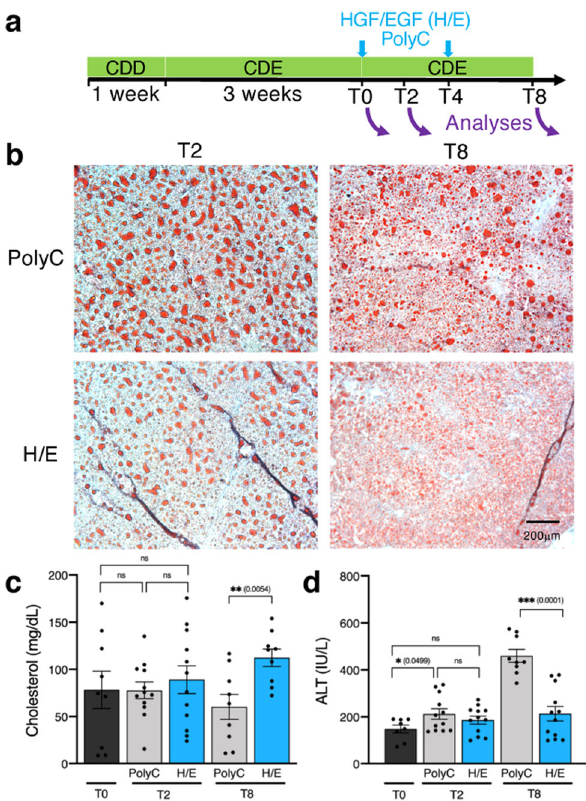
Fig. 5 HGF/EGF mRNA-LNP ameliorate liver function during continuous CDE-induced chronic liver injury. a Injury scheme timeline: mice were fed CDD choline de fi cient diet for 1 week followed by continuous CDD diet supplemented with 0.1% ethionine (CDE) for 4 weeks. Mice were injected with either Poly(C) RNA-LNP or HGF/EGF(H/E) mRNA-LNP after 3 weeks of CDE diet (T0), followed by another round of injections 4 days later (T4). Mice were analyzed at T2 and T8, 2 days and 8 days after the fi rst mRNA- LNP administration. b Bright- fi eld images at ×100 magni fi cation of Oil Red O staining show decreased lipid content in H/E mRNA-LNP treated mice at T8 compared to T2 and compared to control Poly(C) RNA-LNP treated groups. Representative images from 4 mice per group per time point are shown. The scale bar represents 200 μ m for all ×100 magni fi cation images. Analyses of total serum cholesterol levels ( c ) and ALT levels ( d ) in 3 – 4 mice per group in duplicate or triplicate ( n = 8 – 12) per time point indicate signi fi cant release of cholesterol into the serum and amelioration of serum ALT to baseline levels in H/E mRNA-LNP treated mice compared to those in Poly(C) RNA- LNP treated group. Data are presented as mean values ±SEM. Dark grey: T0, light grey: control RNA, blue: combined mRNA. P values were calculated by two-sided student ’ s t test, ***<0.0001, **<0.001, *<0.05, n.s. = not signi fi cant. Source data are provided as a Source Data fi